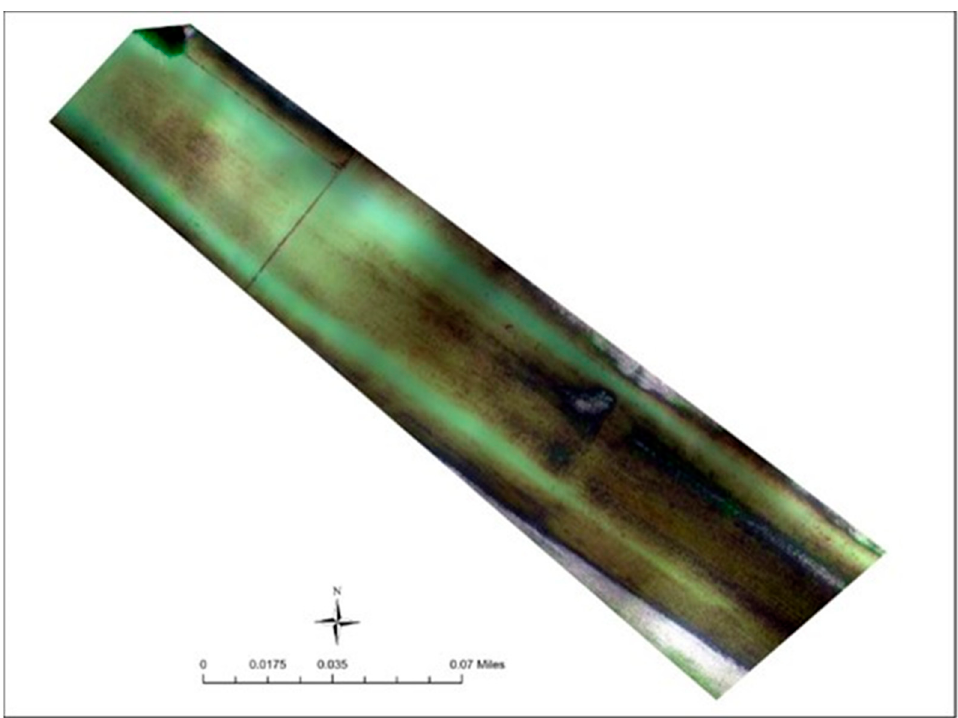
Figure 2. Drone image of standing flood water occupying on average about 75% of the study area from 21st to the 26th of February 2019.